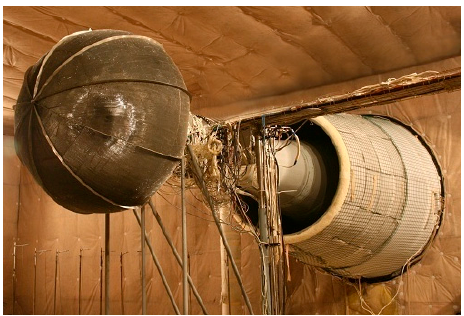
Figure 3. Counter rotating ducted fan technology (CRTF) model fan with TCS installed in the anechoic chamber of the C-3A test facility.